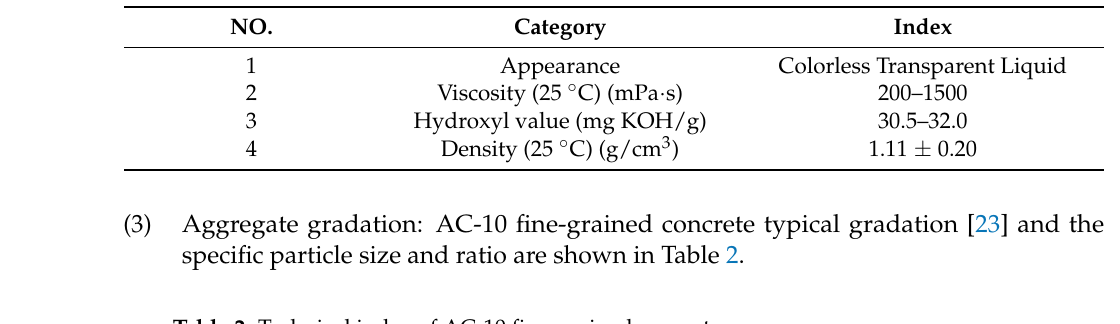
Table 2. Technical index of AC-10 fine-grained